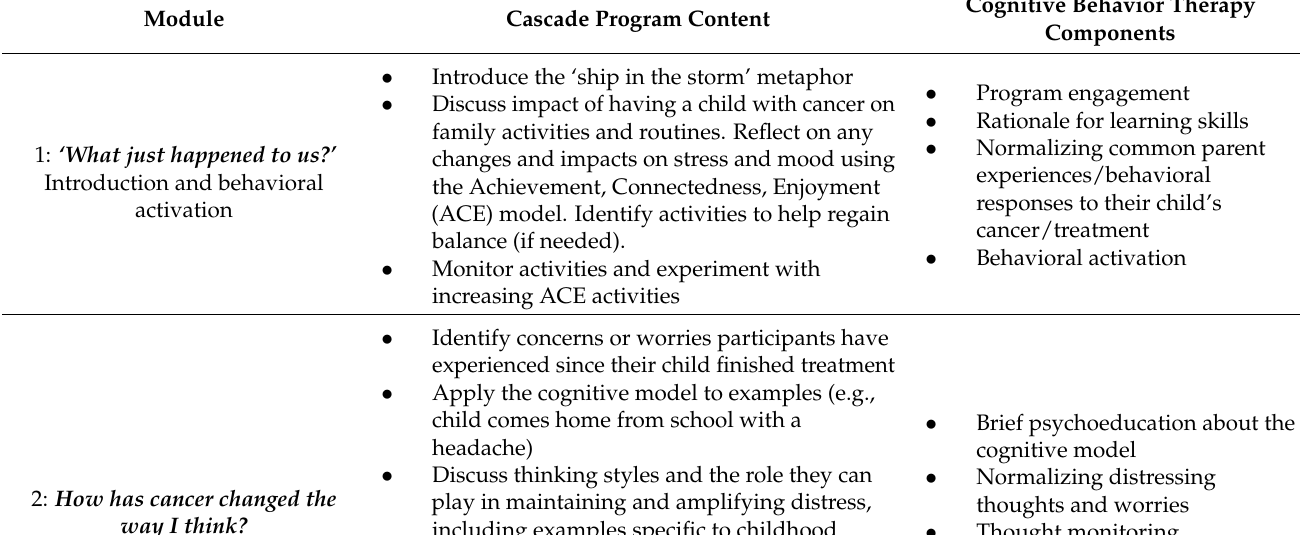
Table 1. Key content within Cascade and underlying cognitive behavior therapy components a .